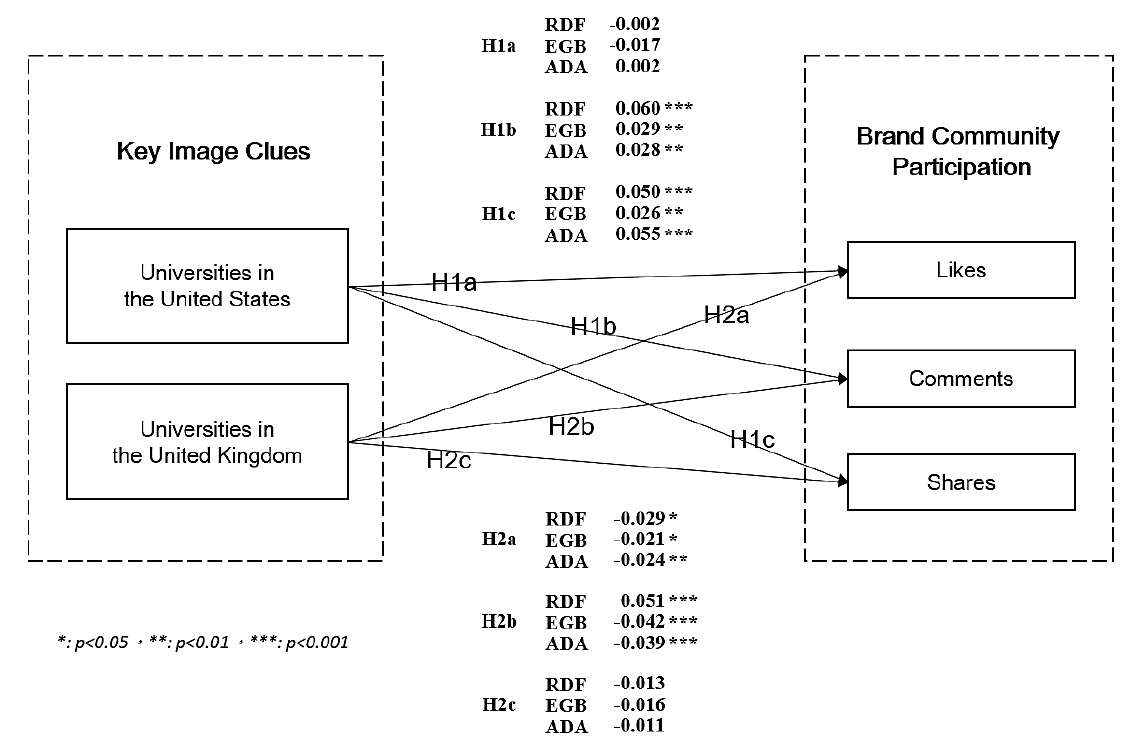
Figure 2. Model results. * : p < 0.05; **: p < 0.01; ***: p < 0.001